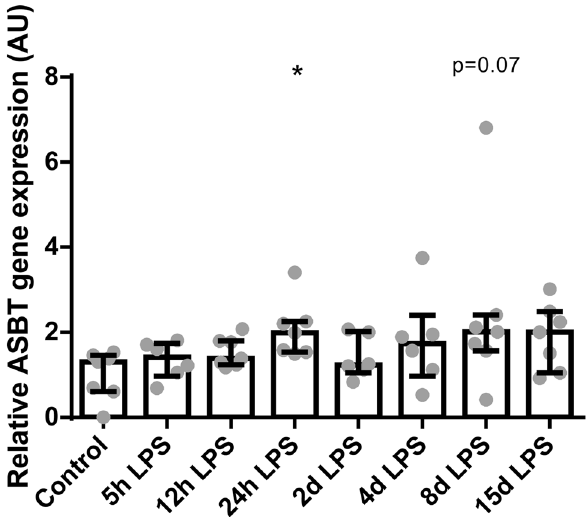
Figure 6. Relative gene expression of ASBT in AU in the terminal ileum. Data are presented as median with IQR. Increased ASBT expression in animals 24 hours and 8 days after IA LPS administration. * P < 0.05 compared to control. P = 0.07 compared to